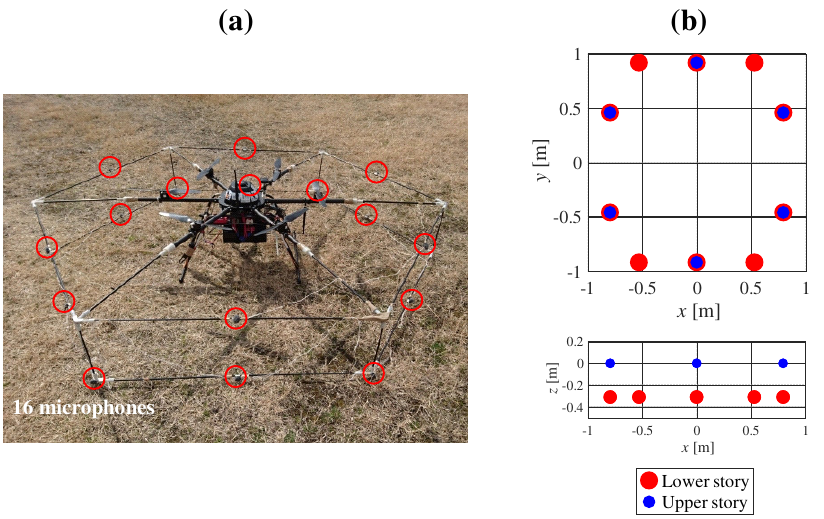
Figure 1. HMAS (hexagonal microphone array system). ( a ) the 16 microphones marked as red circles; ( b ) coordinates of the microphone positions in the